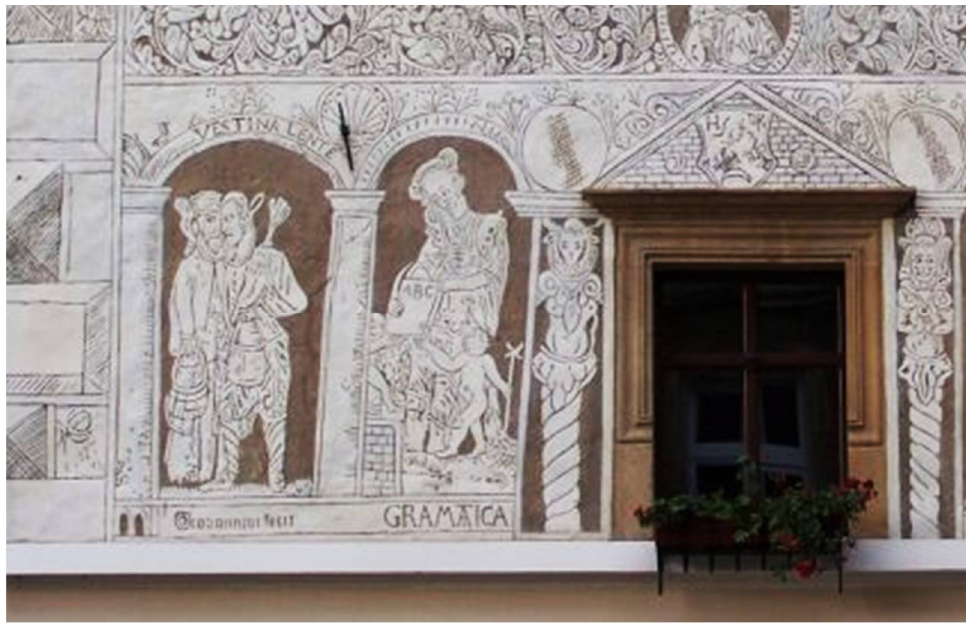
Figure 34. Sgraffito decorations at the Scholz House in Legnica, after conservation in 2006. Author’s photo, 2020.